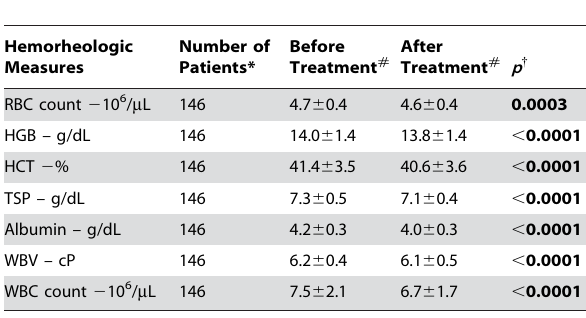
Table 4 presents the results of Spearman partial correlation analyses by controlling for age and gender. Our data showed that before treatment, hemorheologic measures were correlated with HAM-D21 score with a correlation coefficient of 0.21 for WBC count ( p =0.01), 0.18 for RBC count ( p =0.027), 0.24 for HCT RBC measures, and plasma volume percentage were positively correlated with the improvement in HAM-D21 score, although no Table 3. Hemorheologic Measures and WBC Count in MDD statistical significant difference was found for the change in Subjects before (week 2 2) and after (week 8) Treatment hemorheologic measures between remitters and non-remitters. Hemorheologic Number of Measures Patients* Stepwise logistic regression analysis revealed that the significant predictors of remission included HAM-D21 score (OR =0.85,